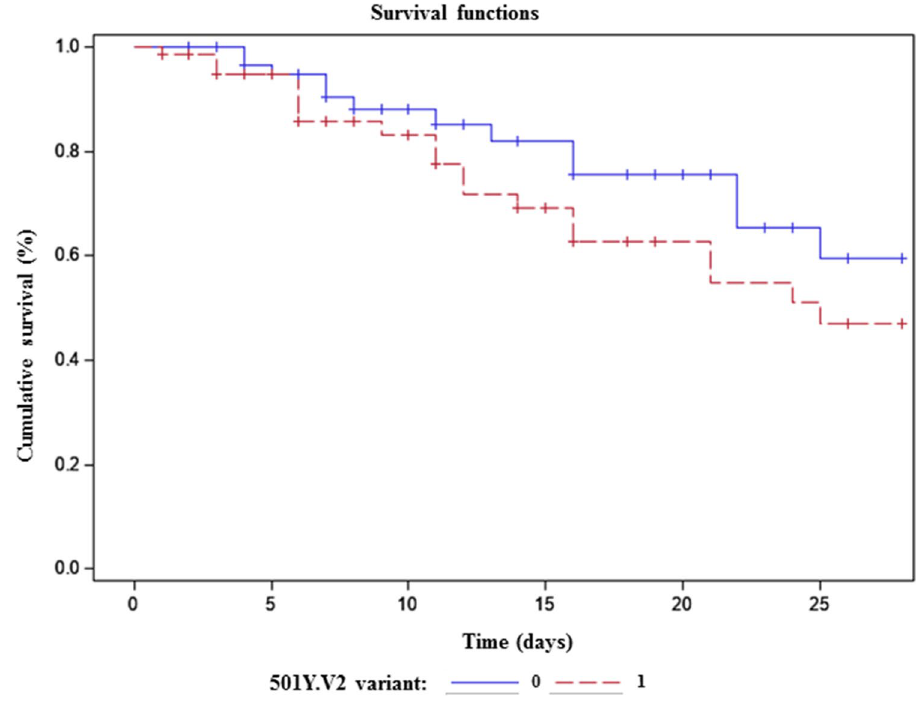
Figure 2. Survival rate for the 124 matched patients ( P = 0.04).